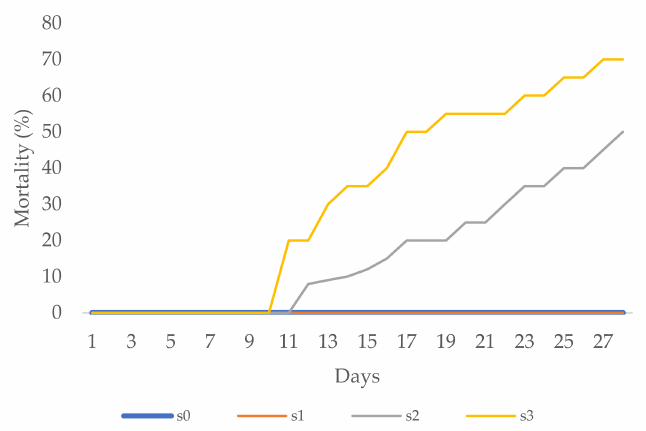
Figure 5. Periwinkle mortality